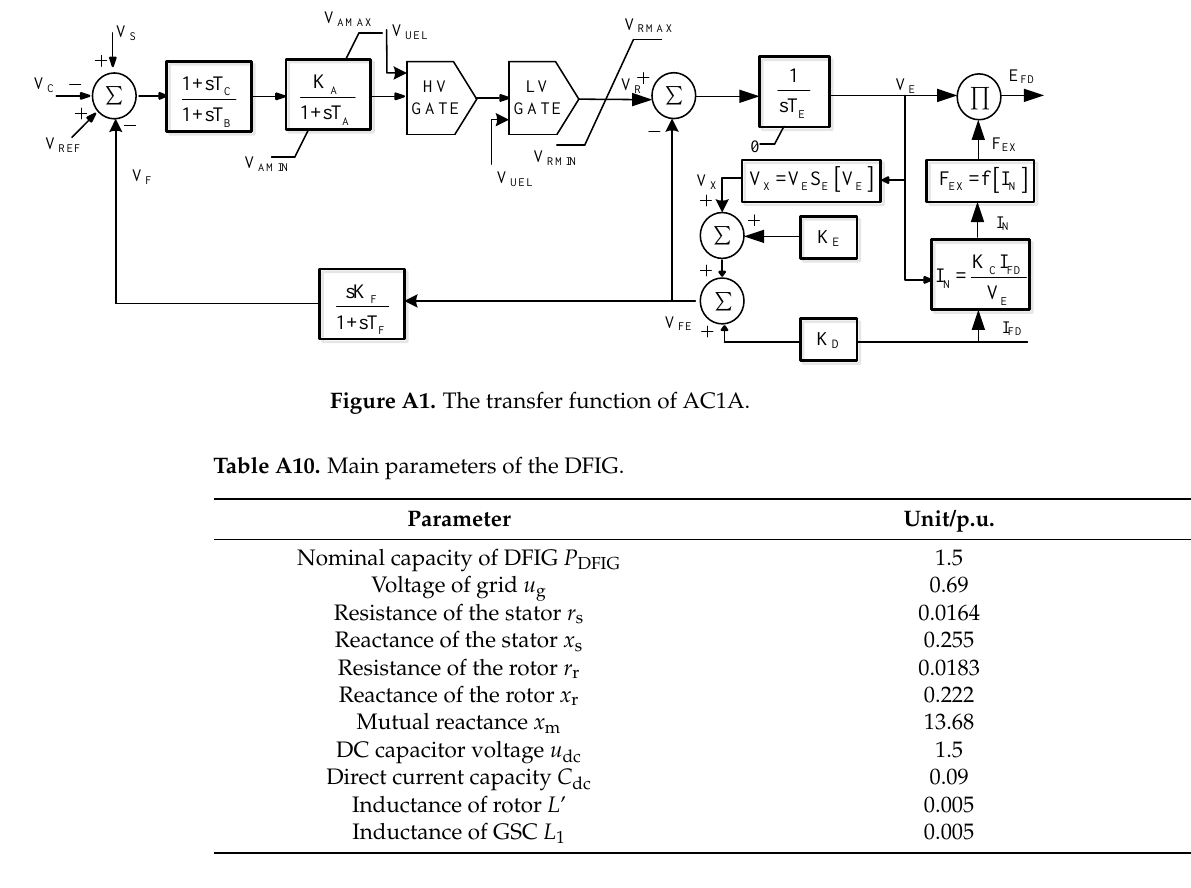
Table A11. Parameters of the HVDC controller.